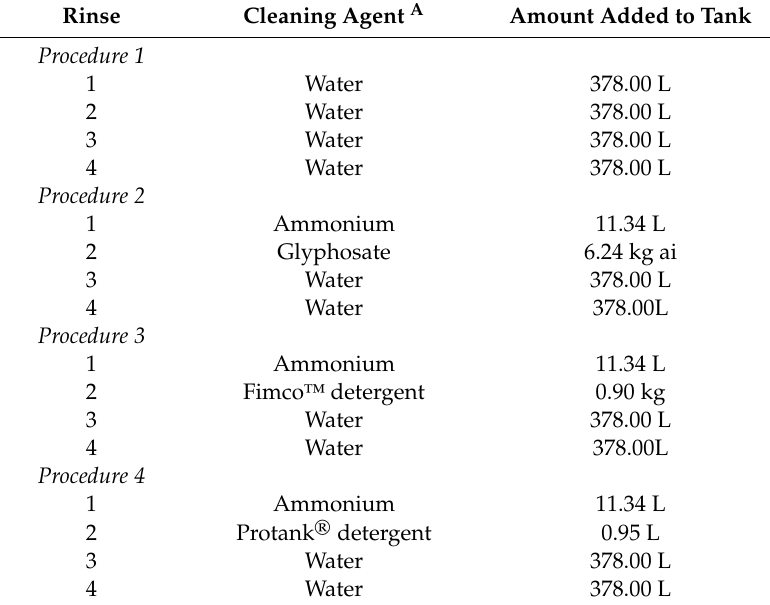
Table 1. Cleanout procedures, agents, and,